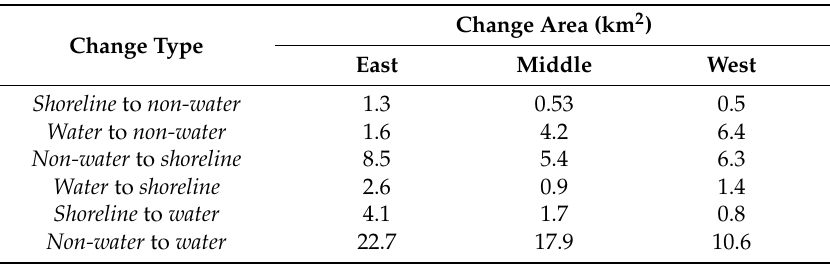
Table 7. Change area in km 2 in the period 1988 up to 2017 with change certainty level ≥ 0.1. Changes to water indicate erosion and changes to non-water show accumulation. The coastal area in the east section experienced the largest loss of land in three